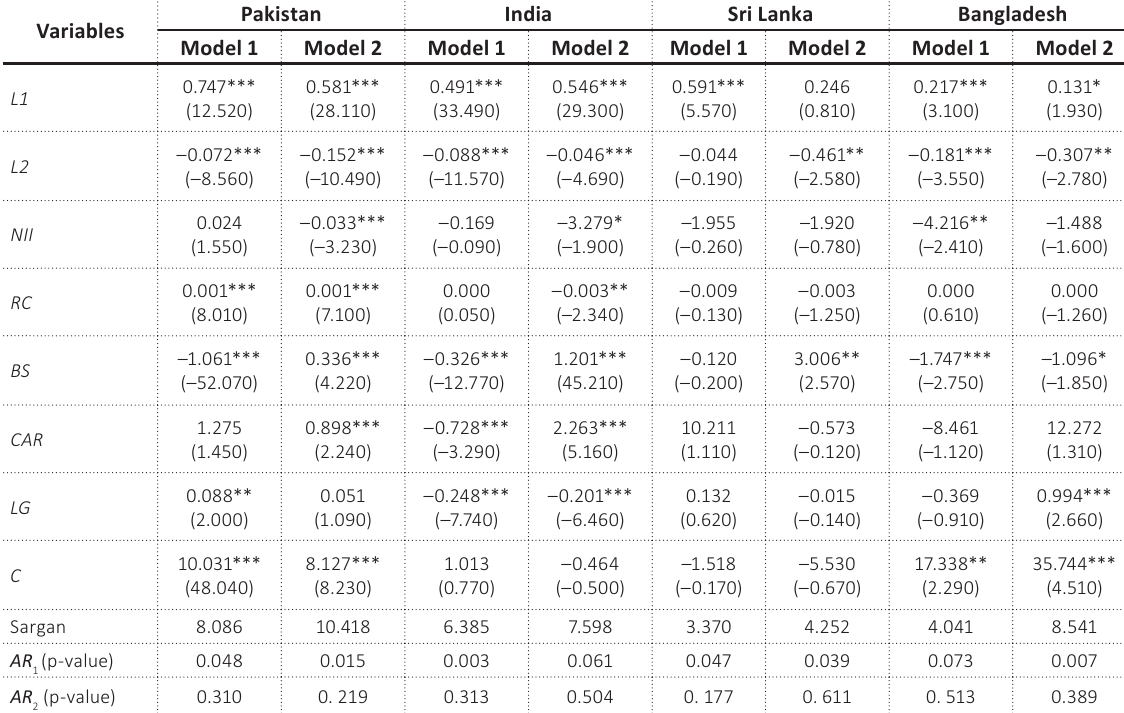
Table 5. Country-wise analysis